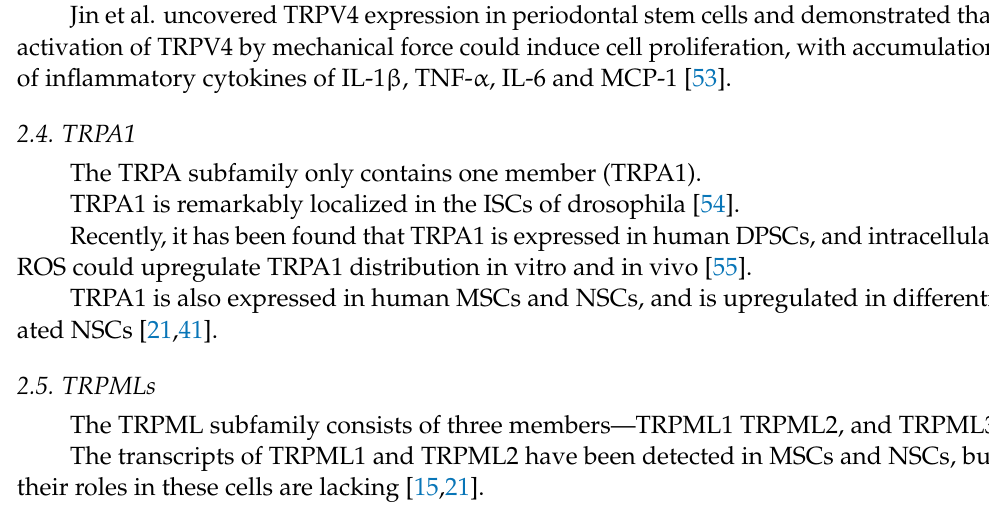
Table 1. TRPs distributed in stem